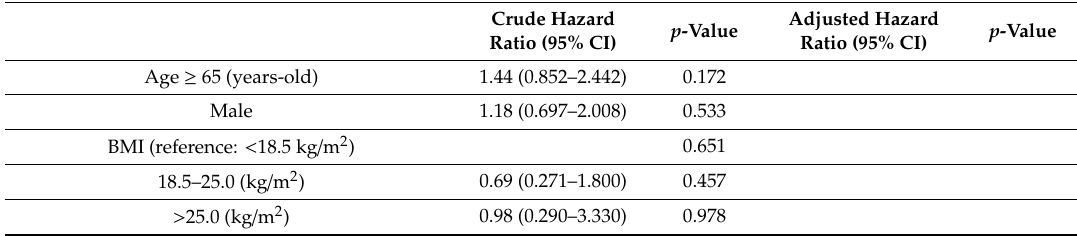
Table 3. Cox regression analysis of disease-free survival for 281 patients with curatively-resected colon